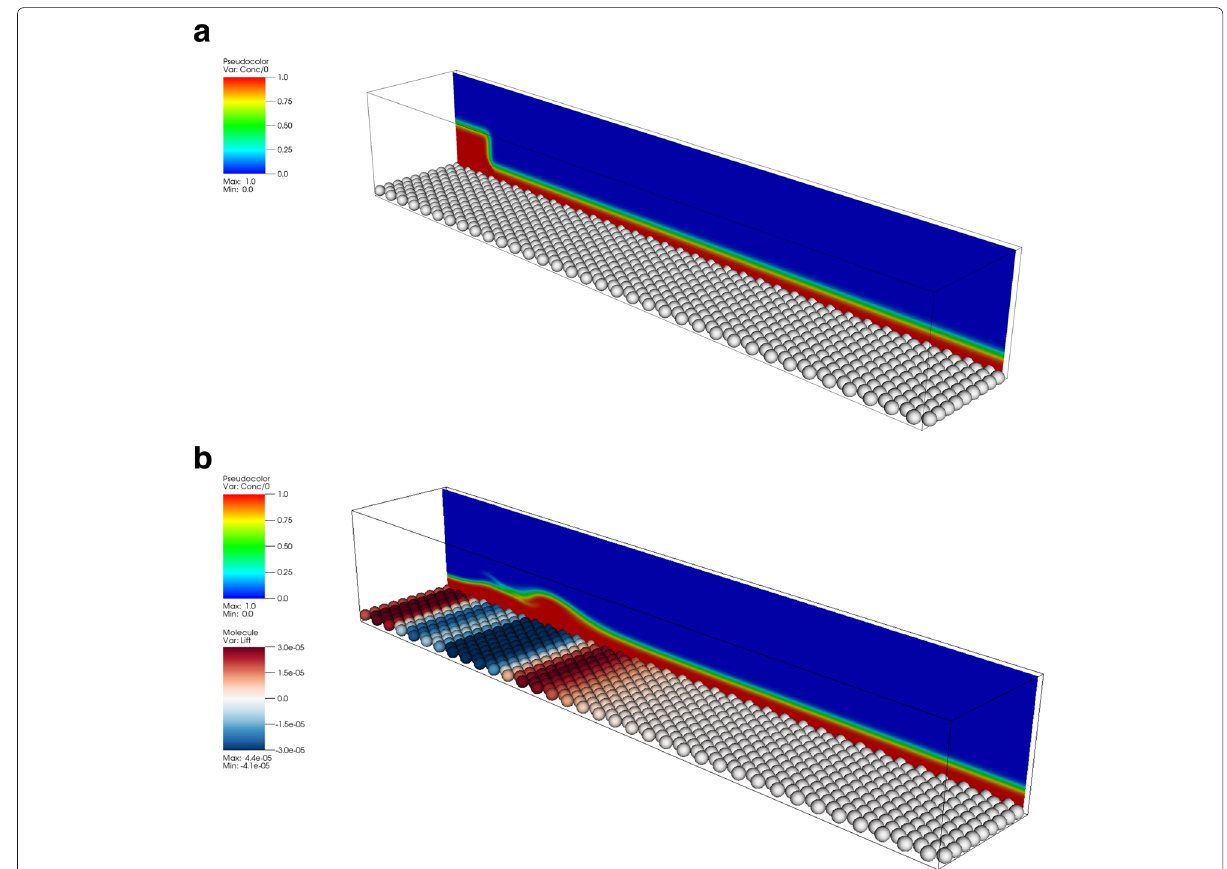
Fig. 8 Instantaneous snapshots for the internal wave study. Fixed particles are arranged in a hexagonal packing immersed in the heavy (red) fluid. a Initially, a lock of dense fluid is arranged at one end of the domain, which then b generates a bore propagating to the right at a later time. The vertical slice shows the concentration profile of the heavy (red) and light (blue) fluids. Particles are colored by the lift force acting on them; red and blue indicate positive and negative forces,